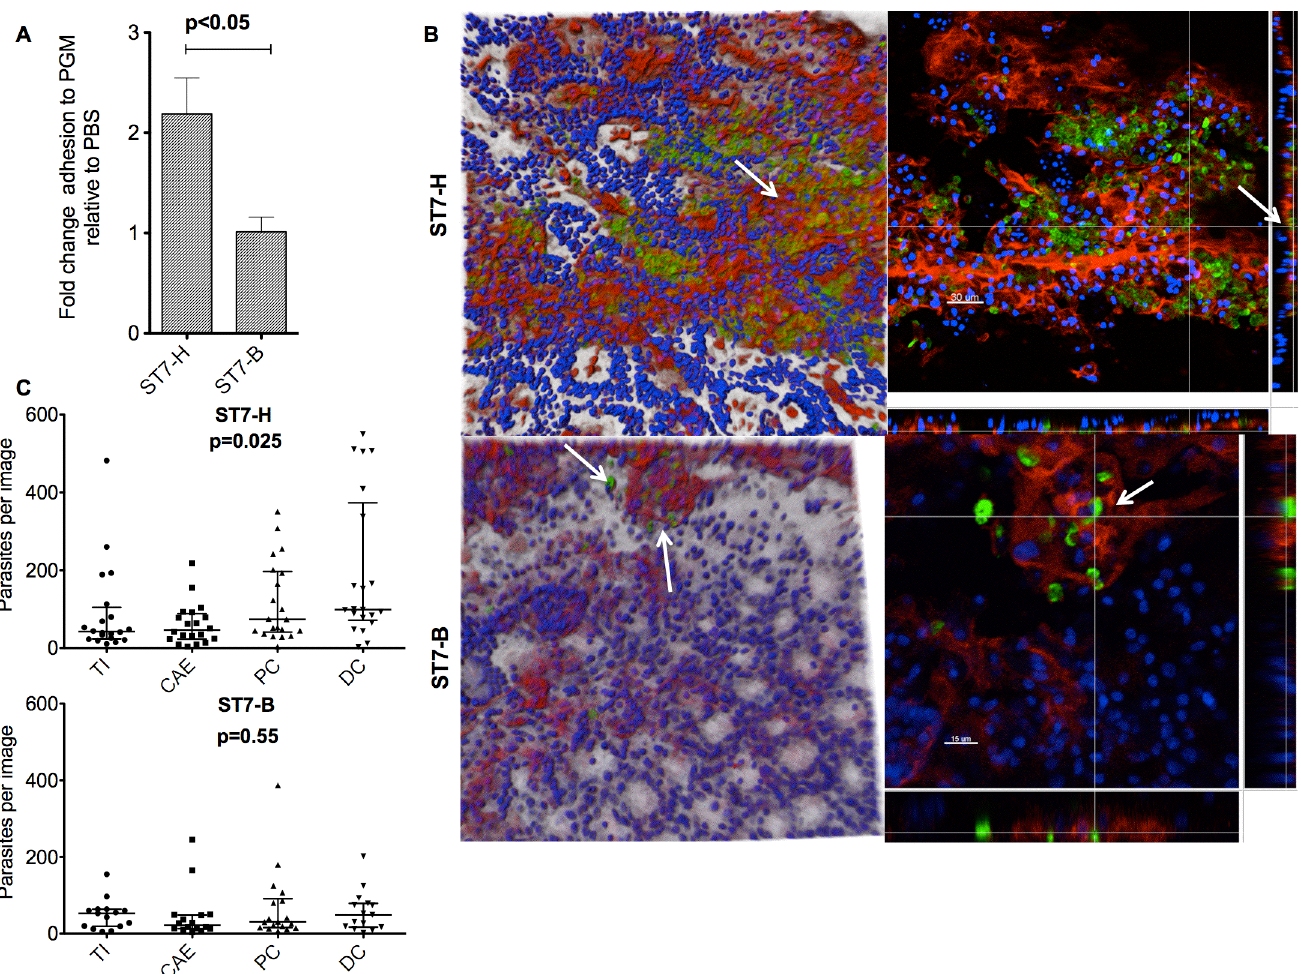
Fig 1. Blastocystis spp. adhesion to mucin on the surface of intestinal explants shows intra-subtype variation. (A) Bar graph represents fold change of Blastocystis spp. adhesion to porcine gastric mucin coated wells relative to PBS coated wells. ST7-H had significantly higher binding than ST7-B. Data representative of 3 independent experiments. (B) Confocal micrographs of mice distal colon incubated with Blastocystis spp. ST7-H and ST7-B showed binding of the parasites to the mucin layer of intestinal explants. Representative images from 5 mice explants are shown. Tissues were incubated with CFSE-stained Blastocystis spp. (green) and counterstained for muc2 (red) and Hoecht for nuclei (blue). (C) Quantitative assessment of Blastocystis spp. adhesion to intestinal explants showed intra-subtype variation and tissue trophic effects. Spot counting data for ST7-H and ST7-B incubated with terminal ileum, caecum, proximal colon and distal colon from at least 5 mice. Horizontal bars represent median and range.